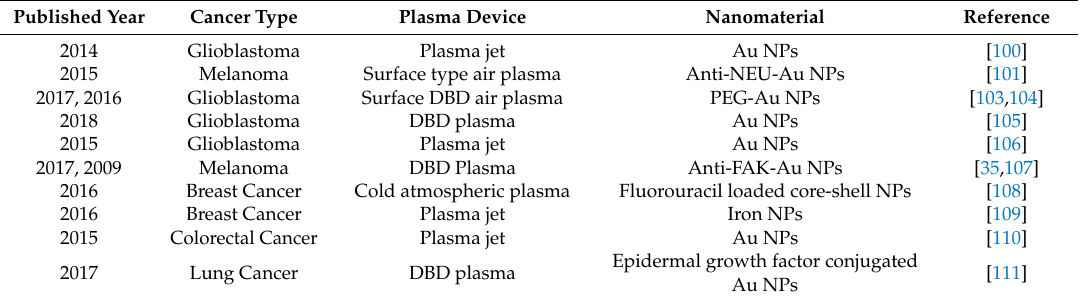
Table 3. Recent updates on plasma and nanomaterial combination treatment against